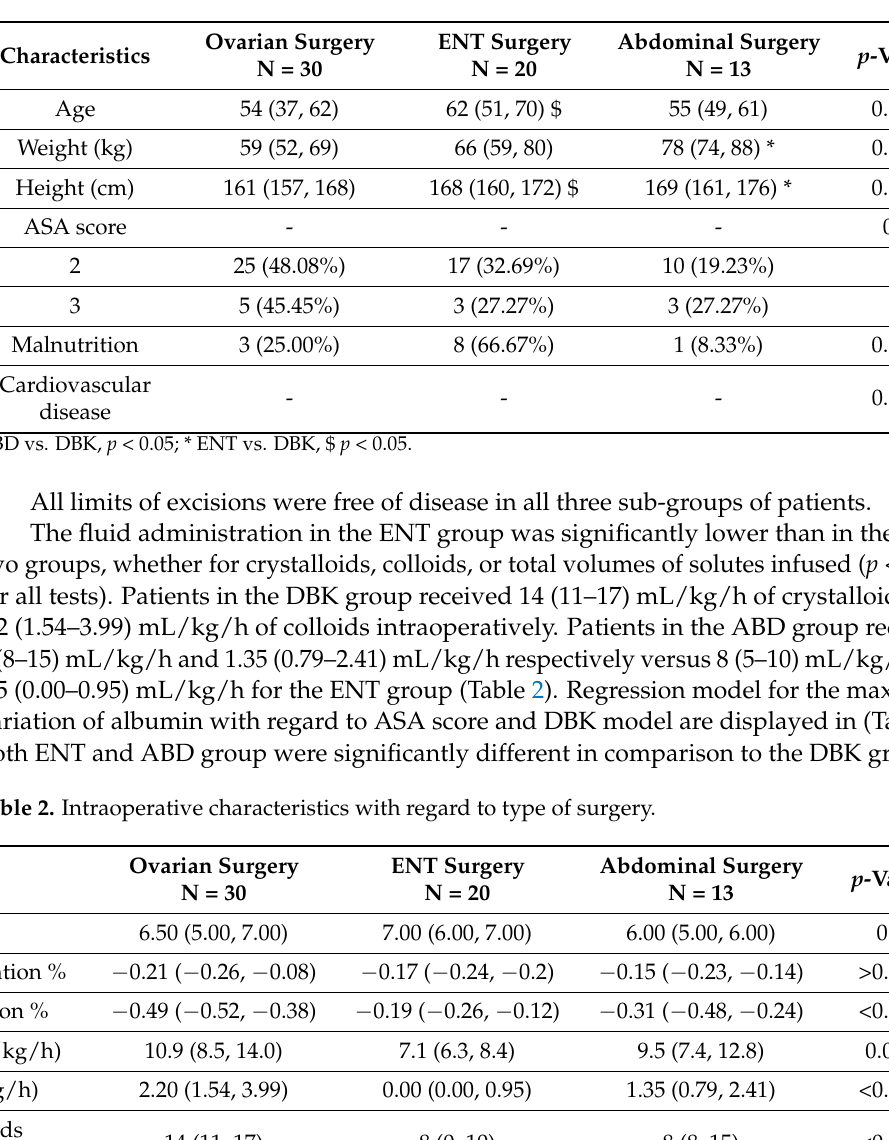
Table 1. Patients characteristics.